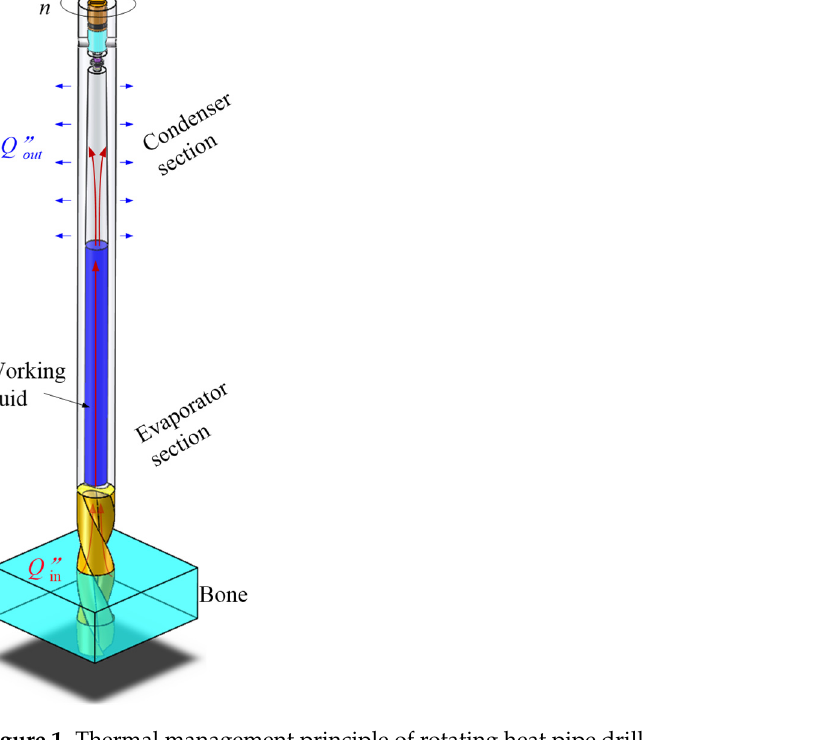
Figure 1. Thermal management principle of rotating heat pipe drill.